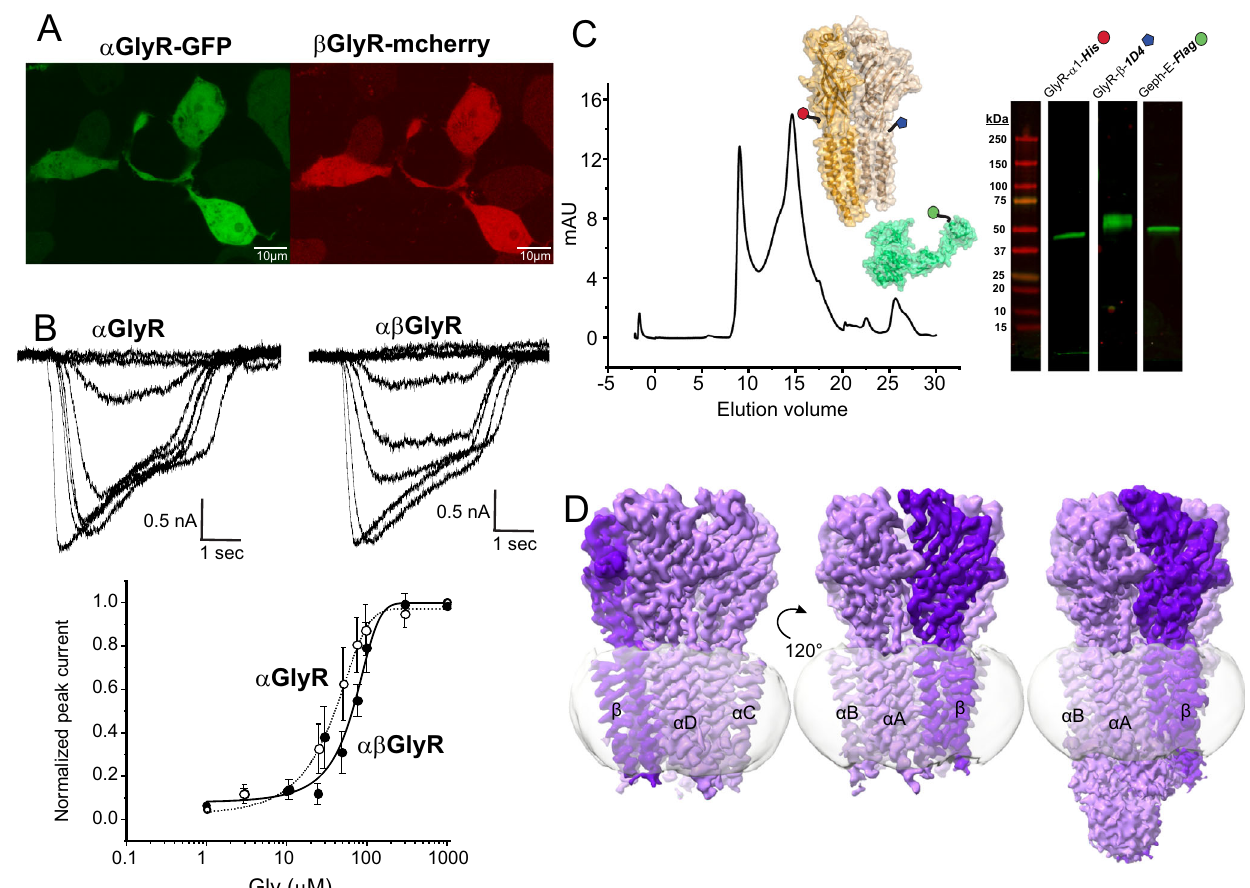
Fig. 1 | Expression, puri fi cation, functional validation, and cryo-EM map of heteromeric αβ GlyR. A Confocal fl uorescent microscopy images of HEK 293Tcells showing GFPand mCherryexpression, whichrespectivelyco-expressed with α GlyRand β GlyRsubunits,viaabicistronicplasmid. β GlyRwastransfectedata 5:1 excess, even though the mCherry fl uorescence appears weaker. Generally, transfection ef fi ciency was around 50%, and similar fl uorescent images were observed for all cell plates used for electrophysiology. B Whole-cell current recordings from HEK 293T cells transfected with only α GlyR (left) and with α GlyR and β GlyR (right) in response to glycine (concentration range: 1 – 1000 μ M). Dose – response curves were generated from recordings on different batches of cells. The EC 50 for α GlyR was 19±11 μ M ( n =5), and for αβ GlyR was 63±13 μ M